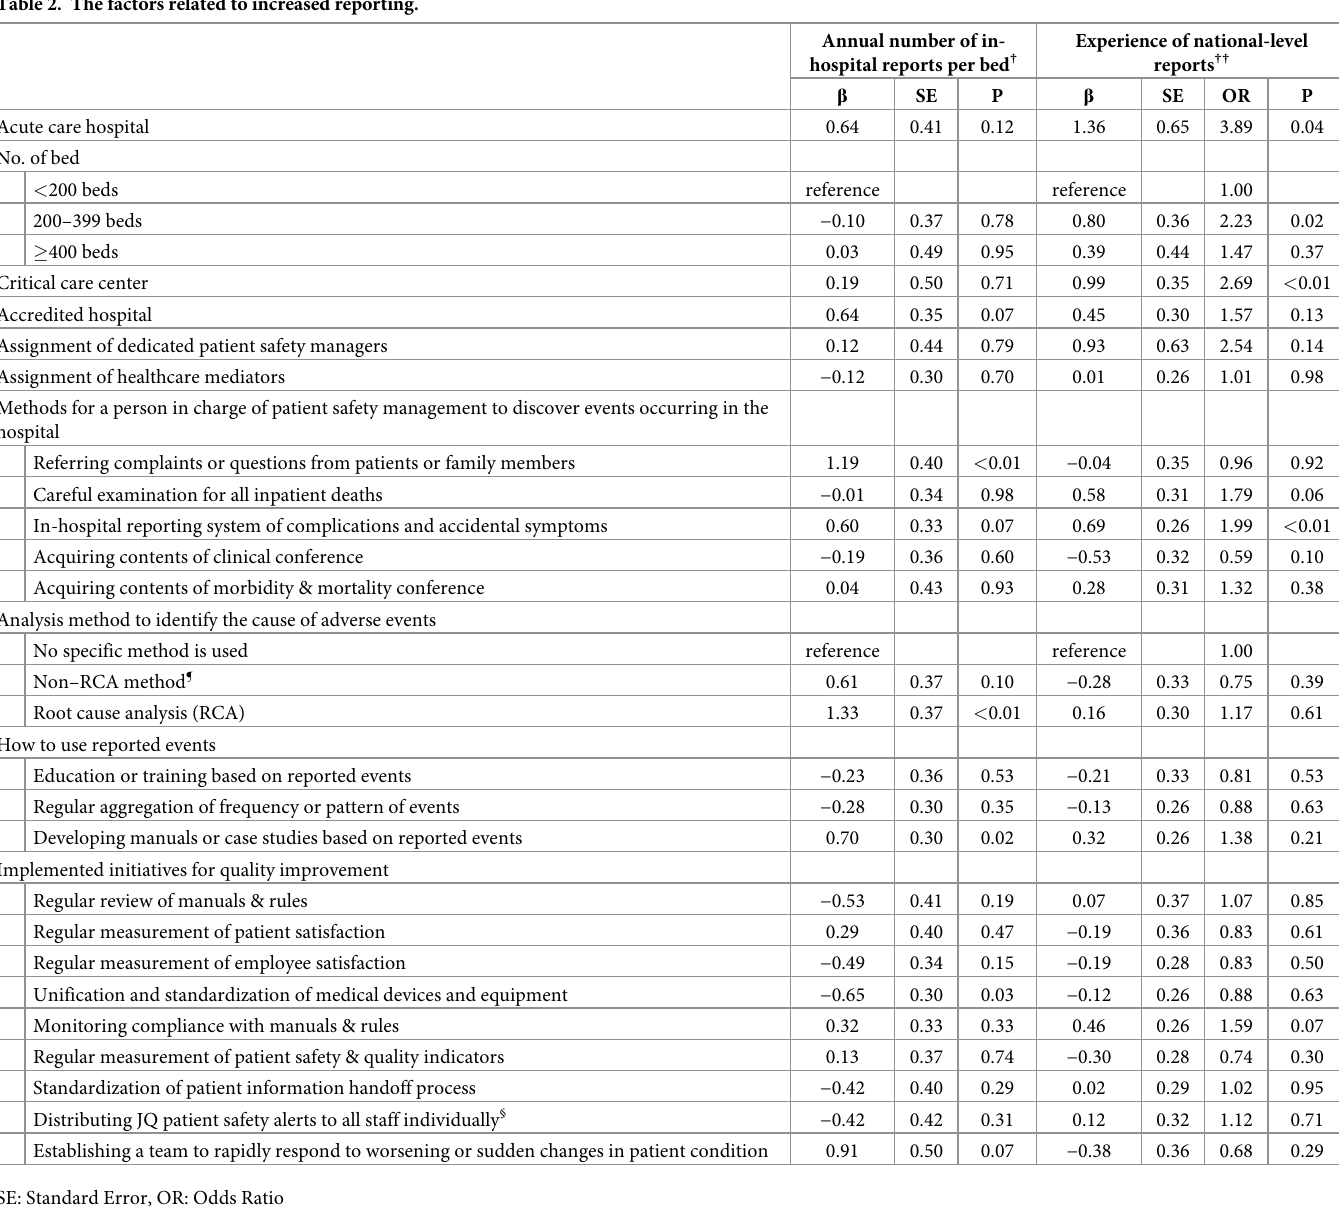
Table 2. The factors related to increased